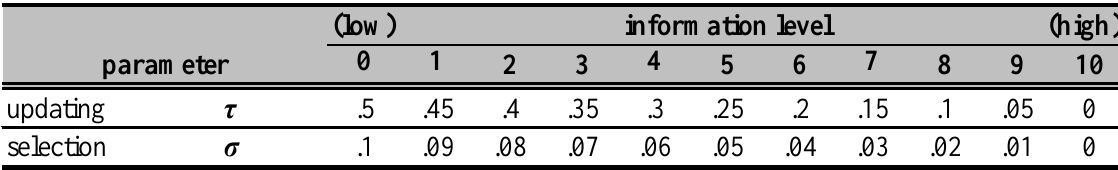
Table 2. Parameter settings relating to traffic information corresponding to information levels which are tested